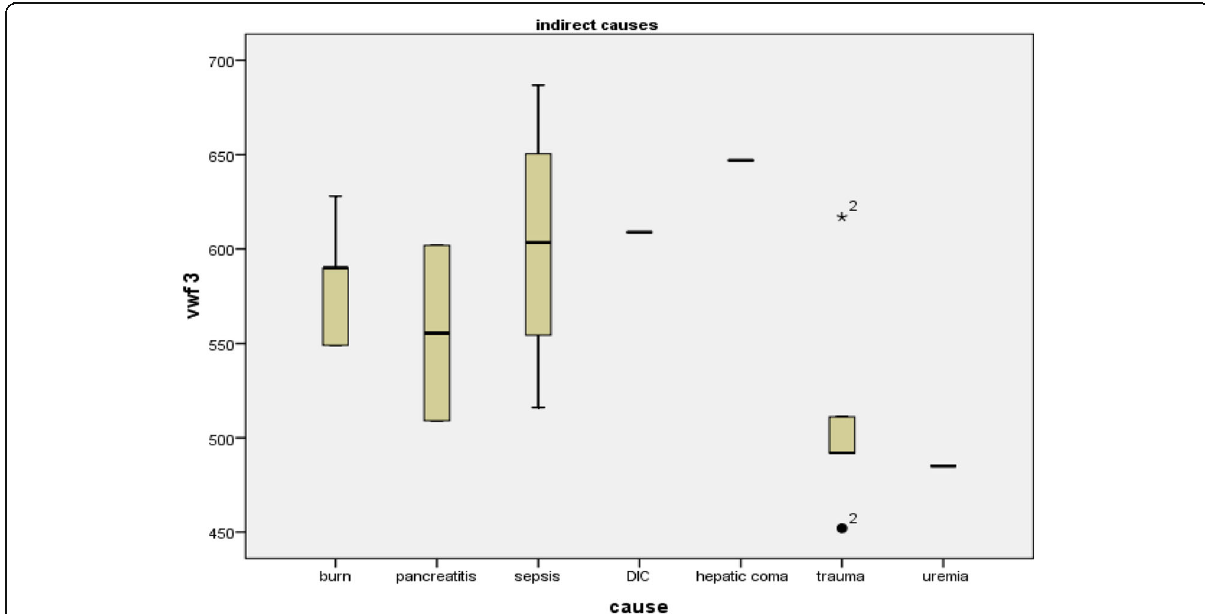
Fig. 1 Different vWF levels among ARDS patients with indirect lung injury vWF 3: day 3 reading of vWF. The middle solid black line represents the median value, the upper and lower margins of the boxes represent the IQR (interquartile range), and the whiskers represent the minimum and maximum